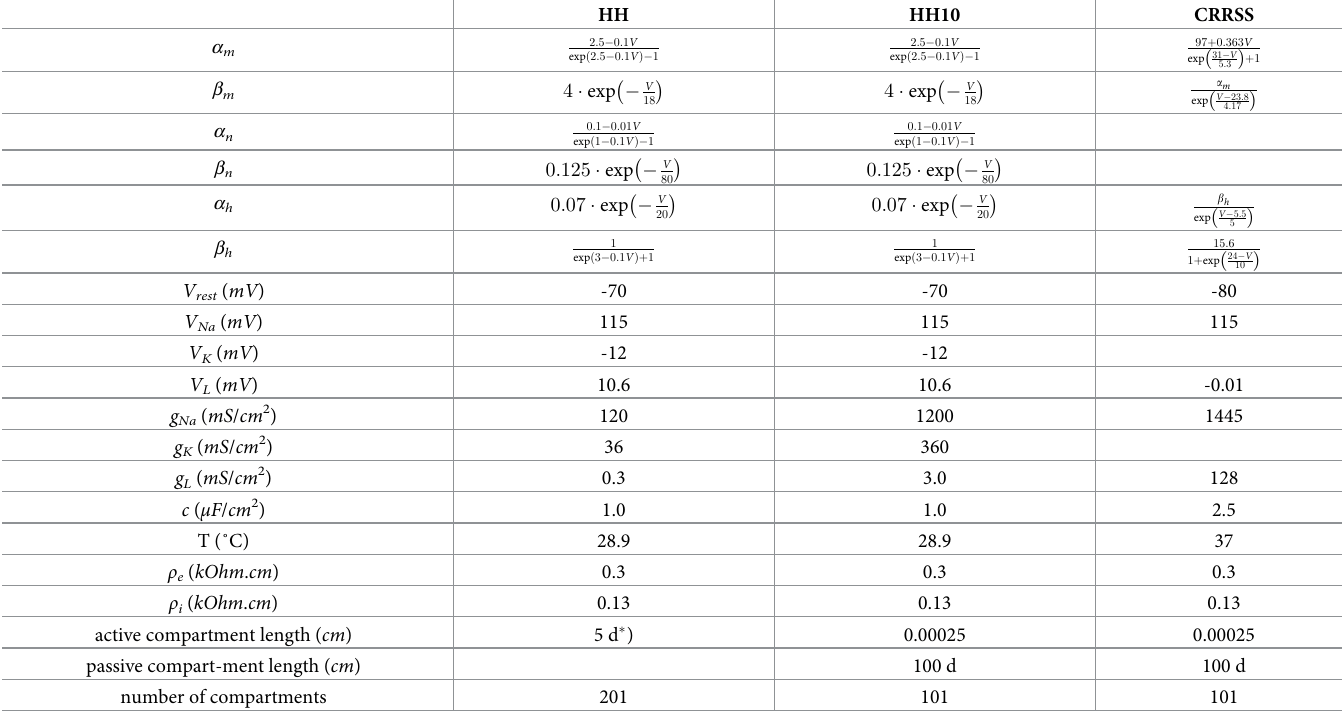
Table 1. Model parameters and formulas for the opening and closing rates of the ion channels.